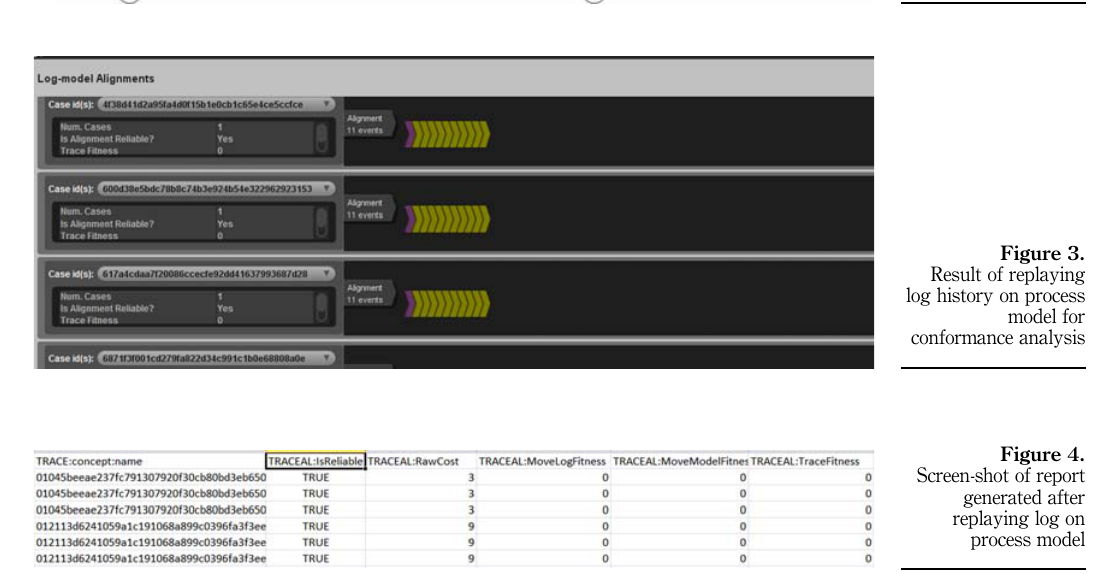
Figure 2. Process model of top